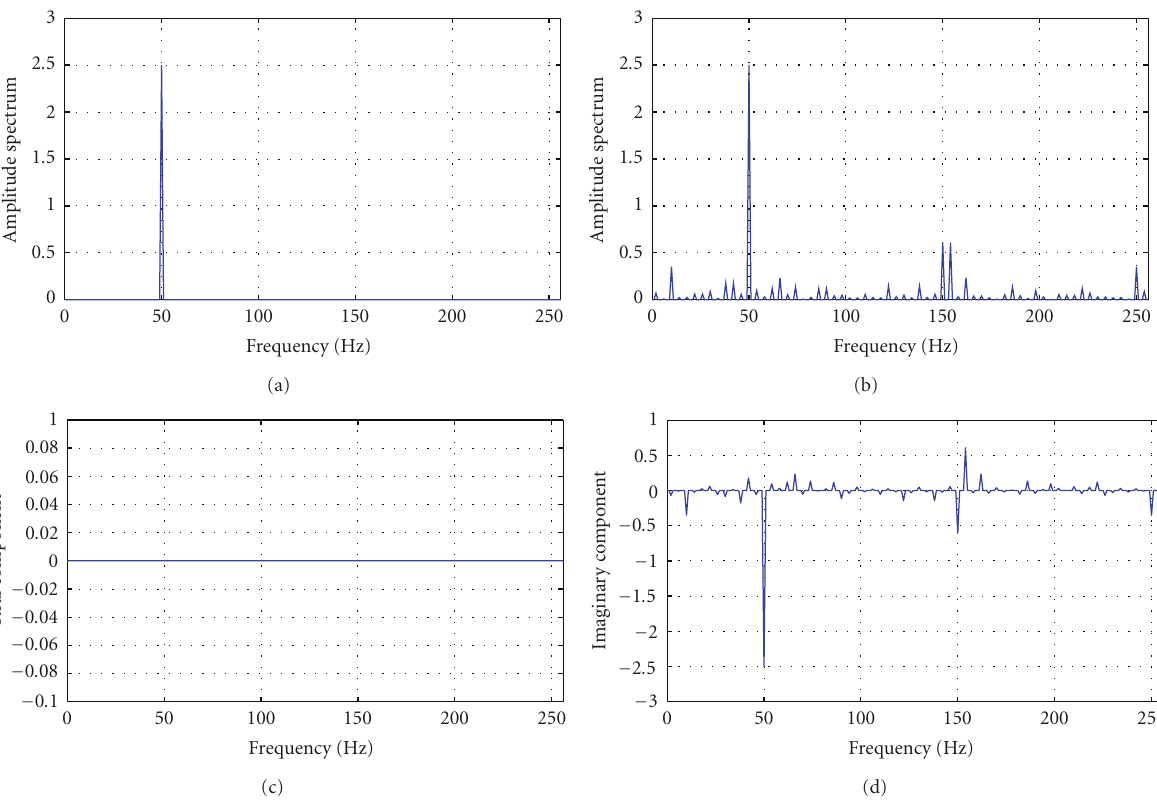
Figure 2: Amplitude spectrum estimates of noise-free signal s 1 ( n ) obtained by standard DFT (a) and RDFT method based on MED (b); R MED ( p ) (c) and I MED ( p )